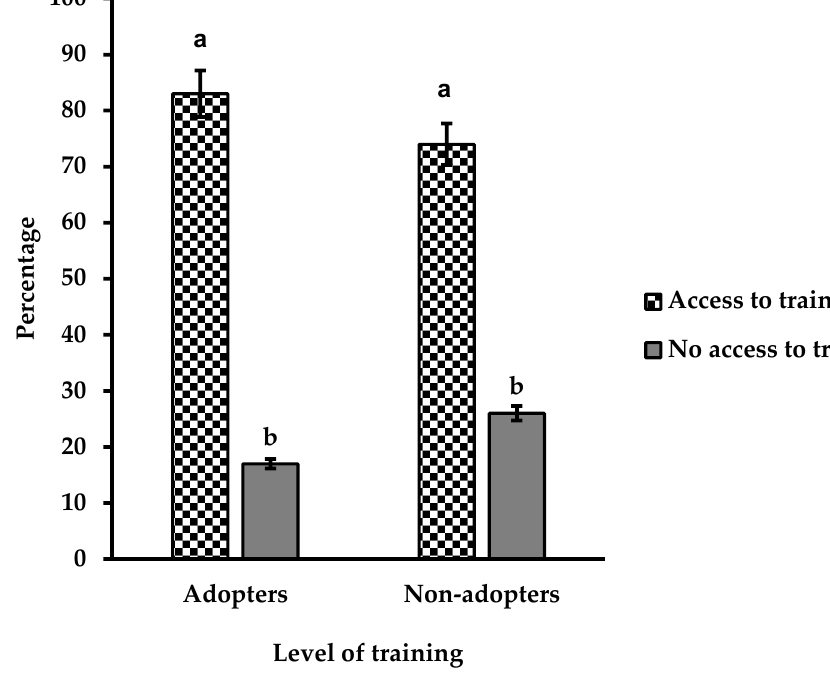
Figure 4. Comparison of SHF access to agricultural training.